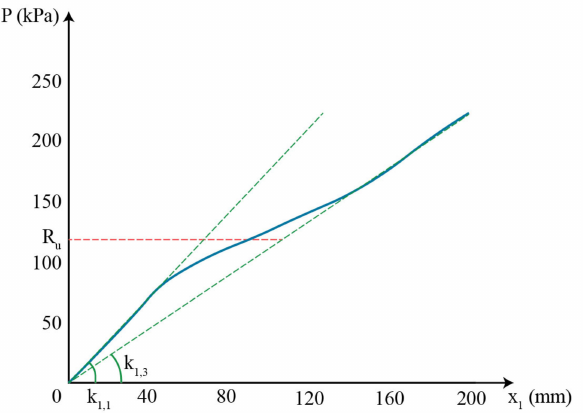
Figure 9. Static pressure–displacement curve (resistance curve) of the trapezoidal sheet considered in the case